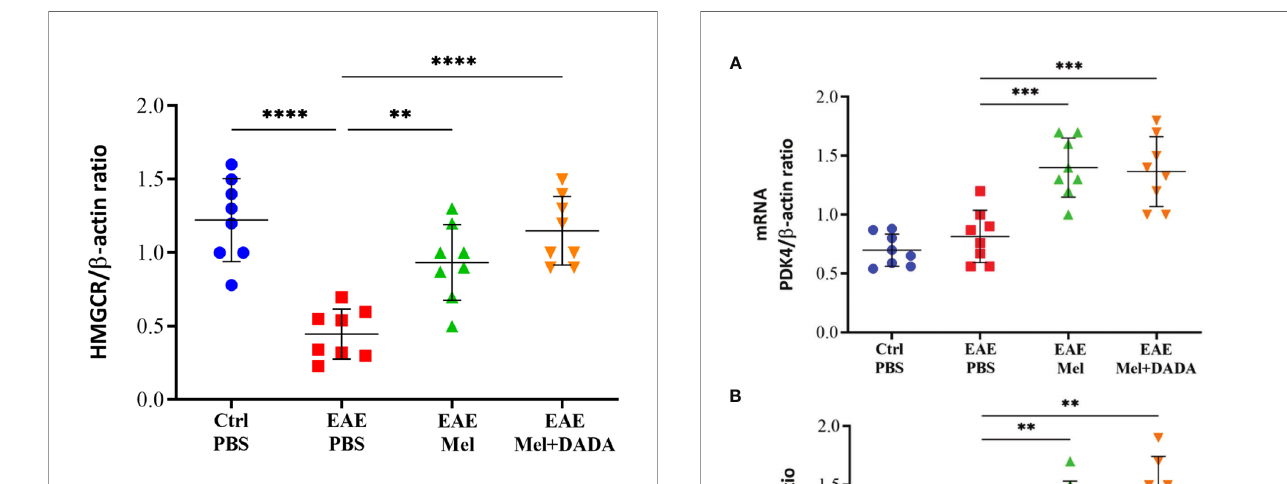
FIGURE 5 | mRNA expression levels of 3-hydroxy-3-methylglutaryl- Coenzyme A reductase (HMGCR) in brain homogenates. b -actin was used as an internal control. Quanti fi cation of HMGCR expression levels was normalized to controls. Values are expressed as the Mean ± SEM. Each group included 8 mice (n = 8). Statistical analysis was performed by two-way analysis of variance (ANOVA) followed by Tukey ’ s test. Signi fi cance is indicated by **p < 0.01 and ****p <